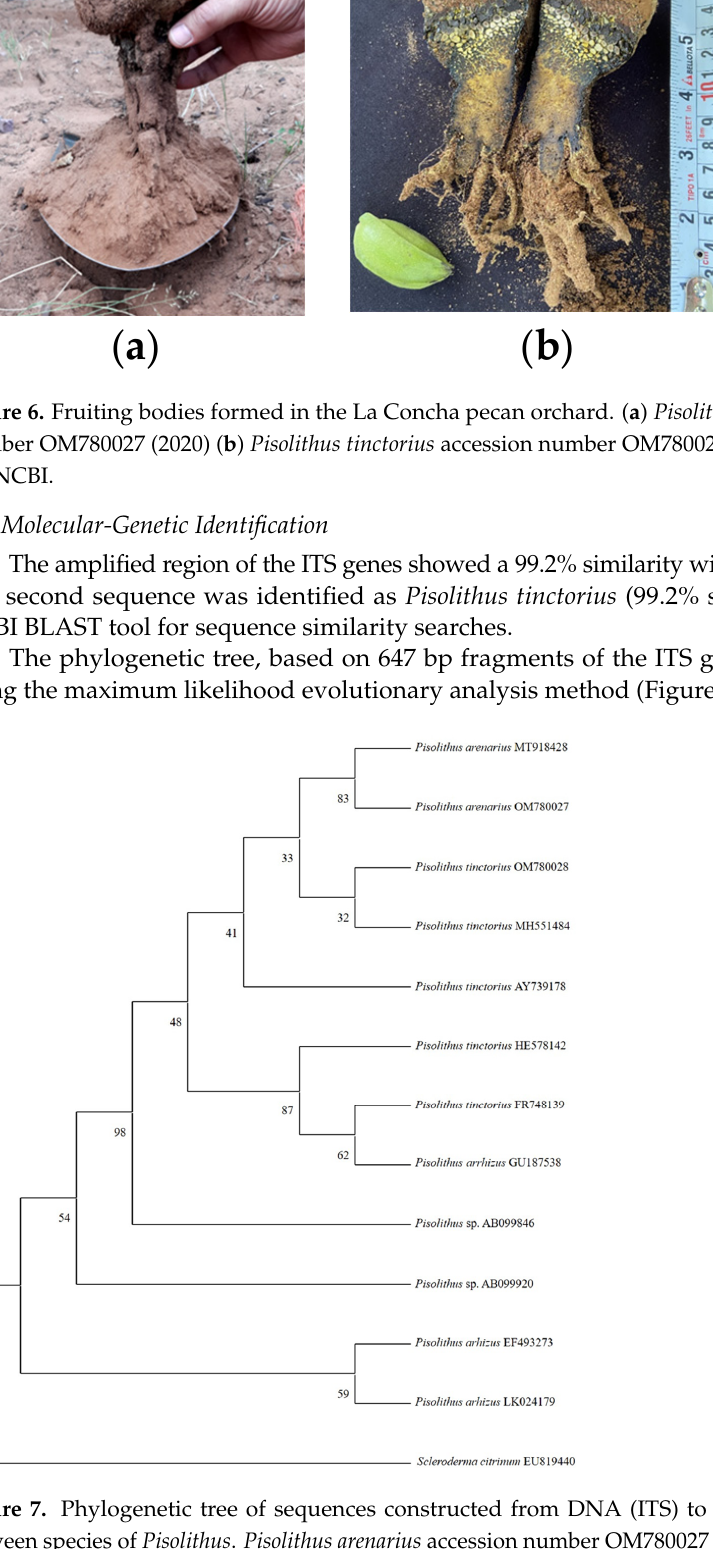
Figure 7. Phylogenetic tree of sequences constructed from DNA (ITS) to estimate relationships be- tween species of Pisolithus . Pisolithus arenarius accession number OM780027 and Pisolithus tinctorius accession number OM780028 were the ECM of this study. The evolutionary history was inferred using the maximum likelihood method and the Kimura 2-parameter model [45], which produced the tree with the highest log proba- bility ( − 2057.29). The percentage of trees in which associated taxa clustered is shown be- low the branches. The initial trees for the heuristic search were obtained automatically by